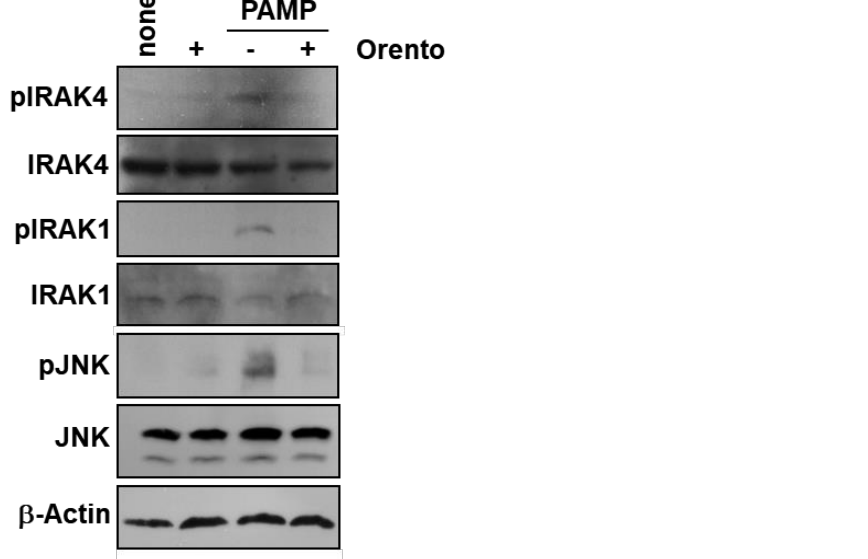
Figure 3. The effects of orento on PAMP-induced protein phosphorylation in CAL27 cells. CAL27 cells were cultured with 10 µ g/mL orento for 24 h and stimulated with 100 ng/mL PAMP for 30 min. The cells were lysed and Western blotting was performed using antibodies against the proteins indicated in the figure.